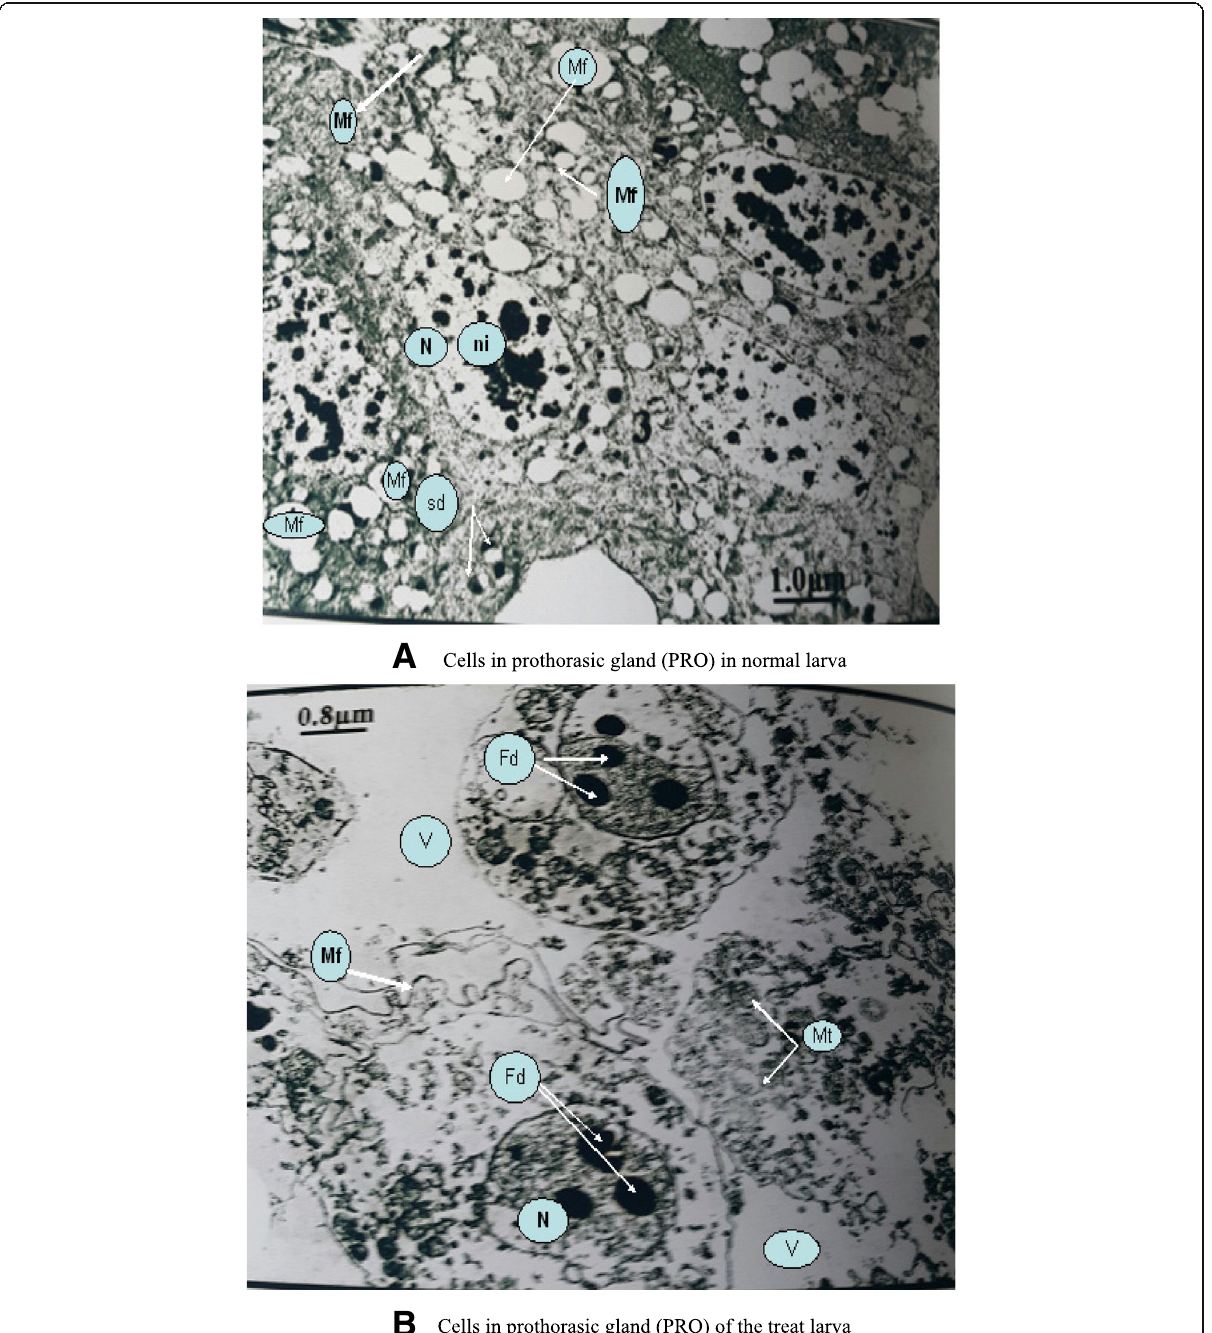
Fig. 9 a Cells in prothoracic gland (PRO) in normal larva. b Cells in prothoracic gland (PRO) of the treated larva. Sections in different tissues of the endocrine system of the potato tuber moth Phthorimaea operculalla larva detected under electron microscope observation . a The normal untreated tissues. b The treated tissues of larva reared on potato tubers covered with talcum powder containing 0.5% each of basil extract + B.t + GV and 25 g/1 kg tuber. Abbreviations: NC neurosecretory cells, CC corpus cardiacum, CA corpus allatum, PRO prothoracic gland, N nucleus, D dendrites, sy synaptic vesicles, V vacuoles, F fat droplets, M cell membrane, Nm nuclear membrane, Cy cytoplasm, A axon, nI necrosis, F fat droplets, Mt